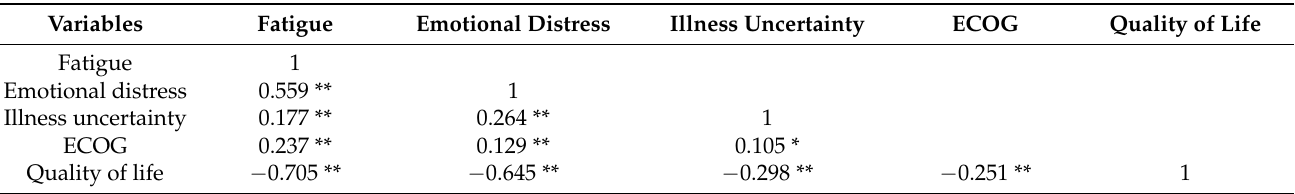
Table 3. Correlations of fatigue, emotional distress, and illness uncertainty with QoL.